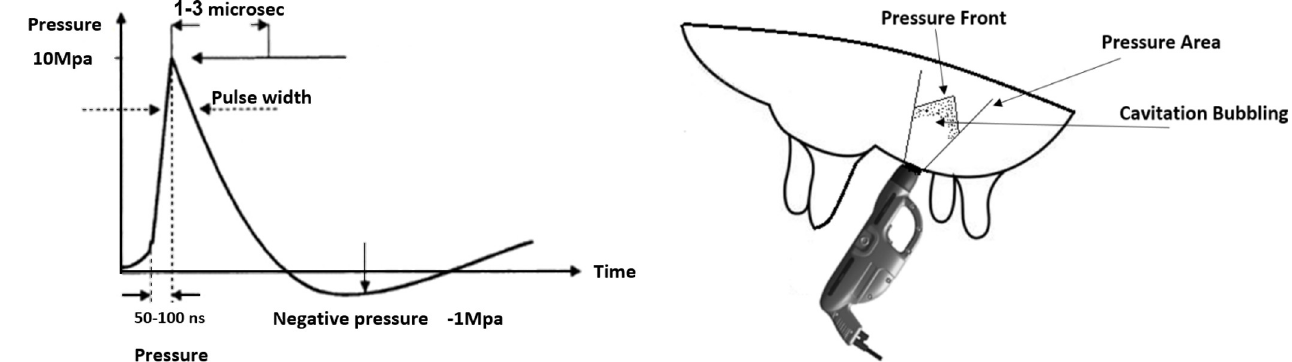
Fig 1. Acoustic pulse wave. An illustrated acoustic pulse wave ( 1A ) and the positioning of the APT-X device on the cow’s udder ( 1B ).